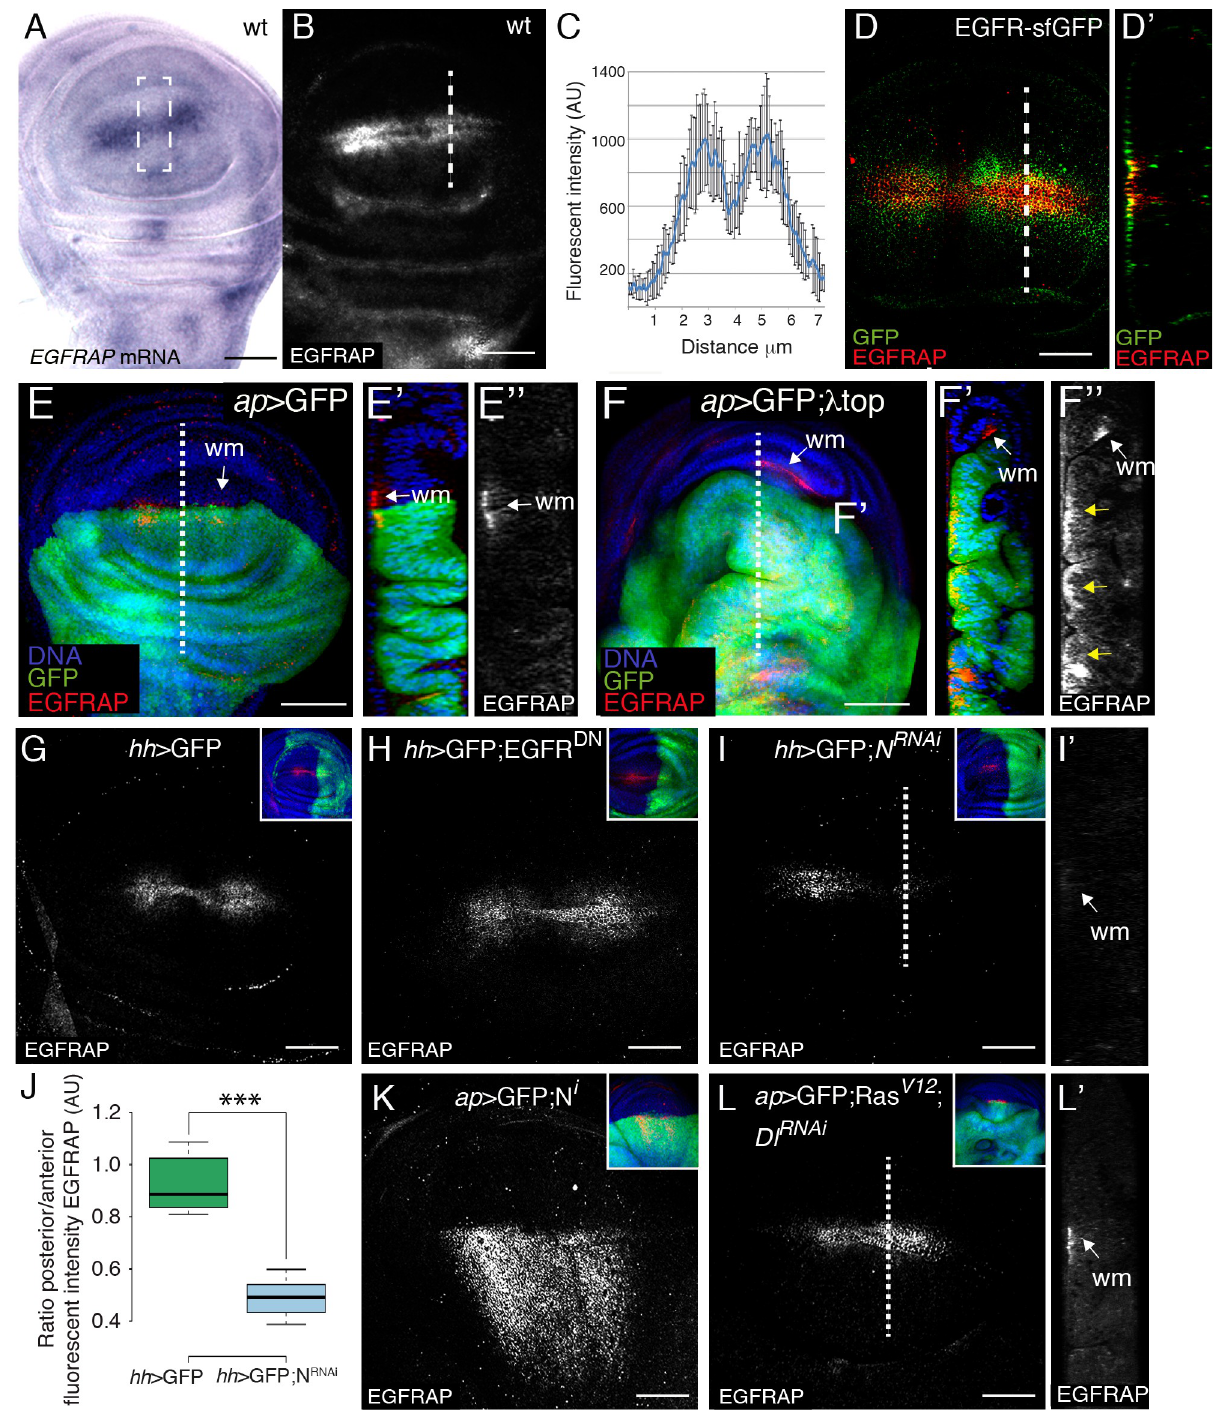
Fig 6. Expression of EGFRAP in Drosophila wing discs. (A) In situ hybridization of a third instar wing imaginal disc with a probe for EGFRAP mRNA. (B) Maximal projection of confocal images of a wild-type (wt) third instar wing imaginal disc stained with anti-EGFRAP. (C) Quantification of EGFRAP levels in the region of the white dotted line in (B). (D) Maximal projection of confocal images of an EGFR-sfGFP third instar wing imaginal disc stained with anti-EGFRAP (red) and anti-GFP (green). (D’) Confocal yz section, along the white dotted line in D. (E, F) Maximal projection of confocal views of wing discs expressing the indicated UAS transgenes under the control of ap -Gal4 stained with anti-GFP (green), anti-EGFRAP (red) and Hoechst (DNA, blue). (E’-E” and F’-F”) Confocal yz sections along the white dotted lines shown in E and F, respectively. Apical side of wing discs is to the left. White arrows indicate wing margin cells (wm). (G, H, I, K, L) Maximal projection of confocal images of wing discs expressing GFP and